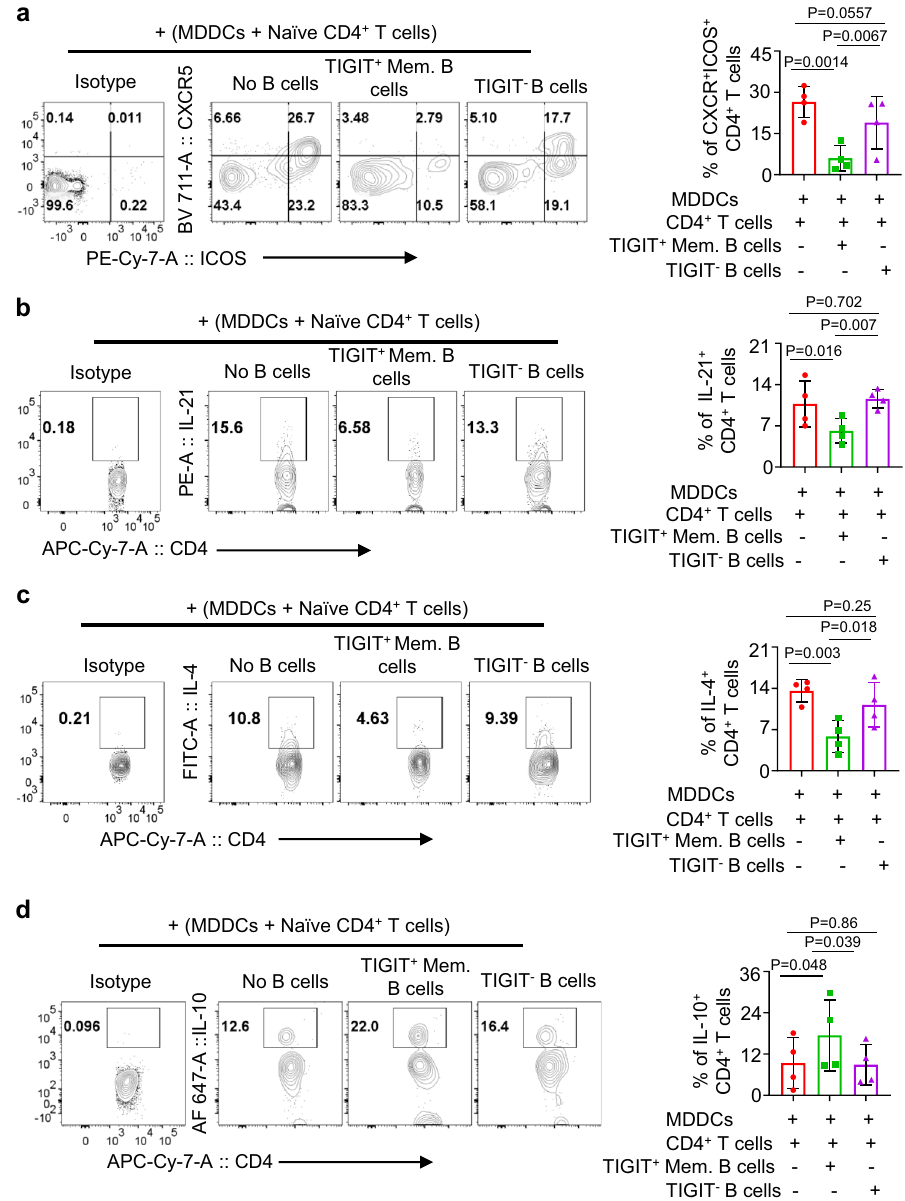
Fig. 7 TIGIT + memory B-cell-modi fi ed DCs suppress the induction of IL-21- and IL-4-producing T cell response, while promoting the induction of IL-10- producing CD4 + T cell response. a – d Representative FACS plots (left panels) and summarized data (right panels) showing the induction of CXCR5 + ICOS + T cell response ( a ), as well as IL-21- ( b ), IL-4- ( c ), and IL-10-expressing ( d ) CD4 + T cell response elicited by monocyte-derived dendritic cells (MDDCs) modi fi ed by TIGIT + memory B cells. TIGIT + memory B cells or TIGIT − B cells were cocultured with MDDCs for 2 days in the presence of 100 ng/mL LPS before coculturing them for 7 days with FACS-sorted naive CD4 + T cells (CD4 + CD45RA + CD45RO − CCR7 + ). PMA, ionomycin, brefeldin A, and monensin cocktails were added 5 h before intracellular staining of indicated cytokines. Isotype antibody staining was performed using mixture of CD4 + T cells cultured in three different conditions. Cells were gated based on isotype antibody staining. Data from four independent experiments performed with cells from different healthy individuals ( n = 4). Error bars are mean ± SD. P values were determined with one-way ANOVA with Holm – Sidak ’ s multiple comparison test ( a – d